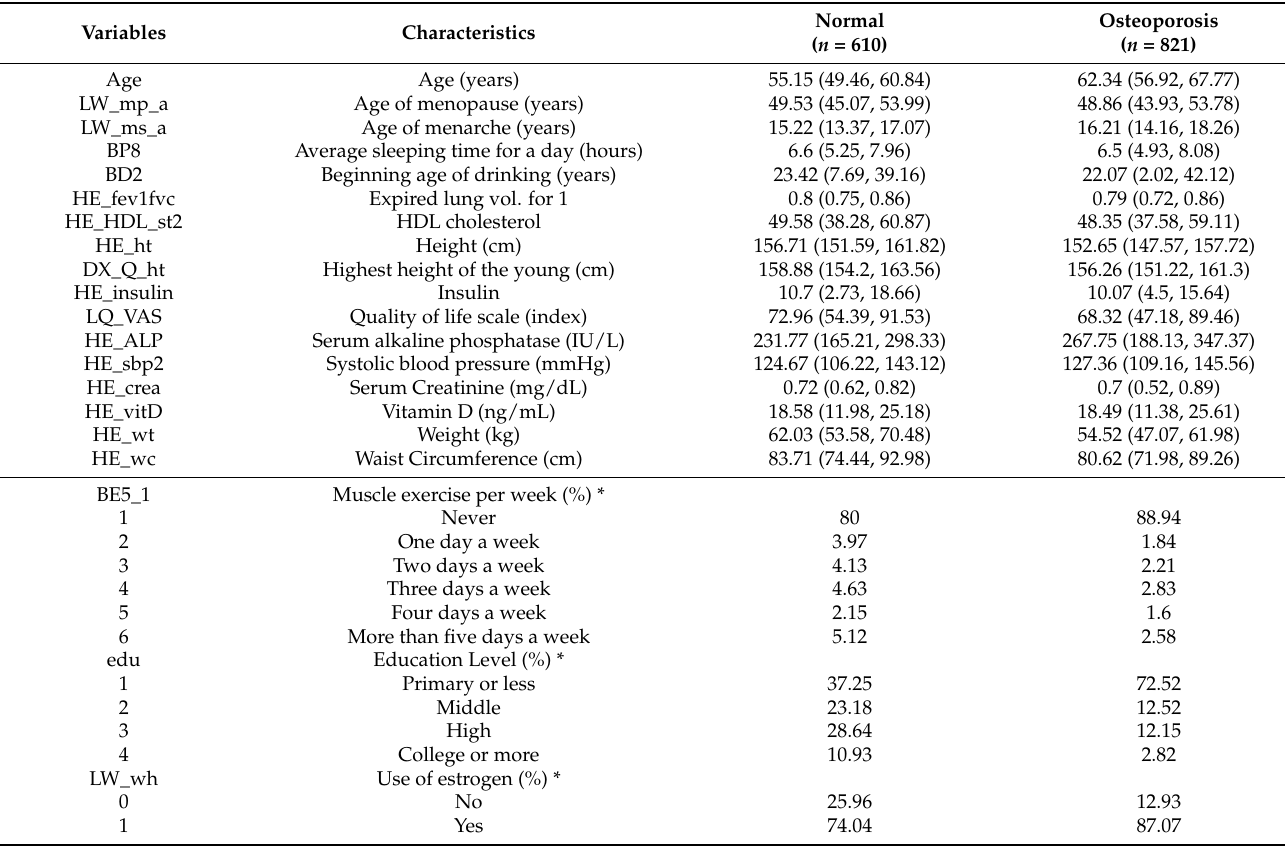
Table 1. Descriptive statistics of normal and osteoporosis subjects in the study.